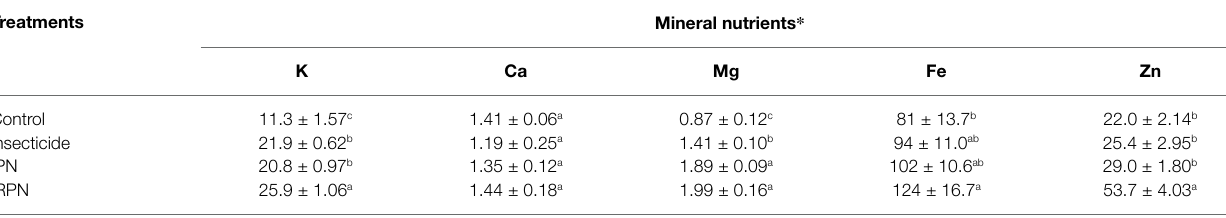
TABLE 2 | Nutrient element content of a single Chinese bayberry from trees grown in different planting environments.